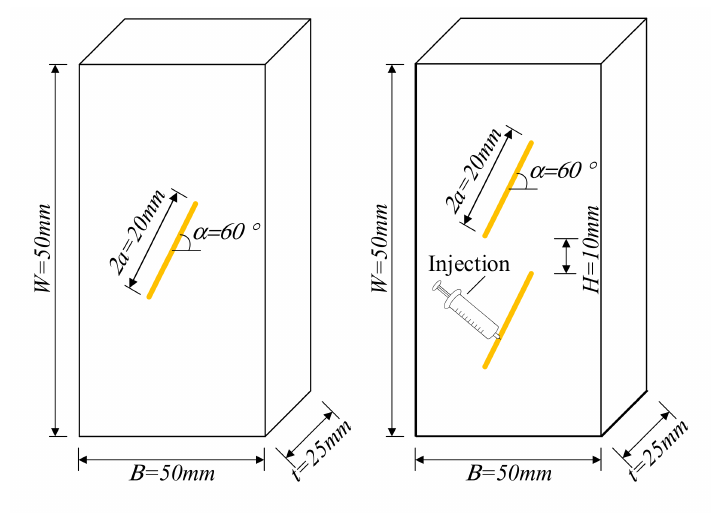
Figure 2. Specimen size and grouting method.